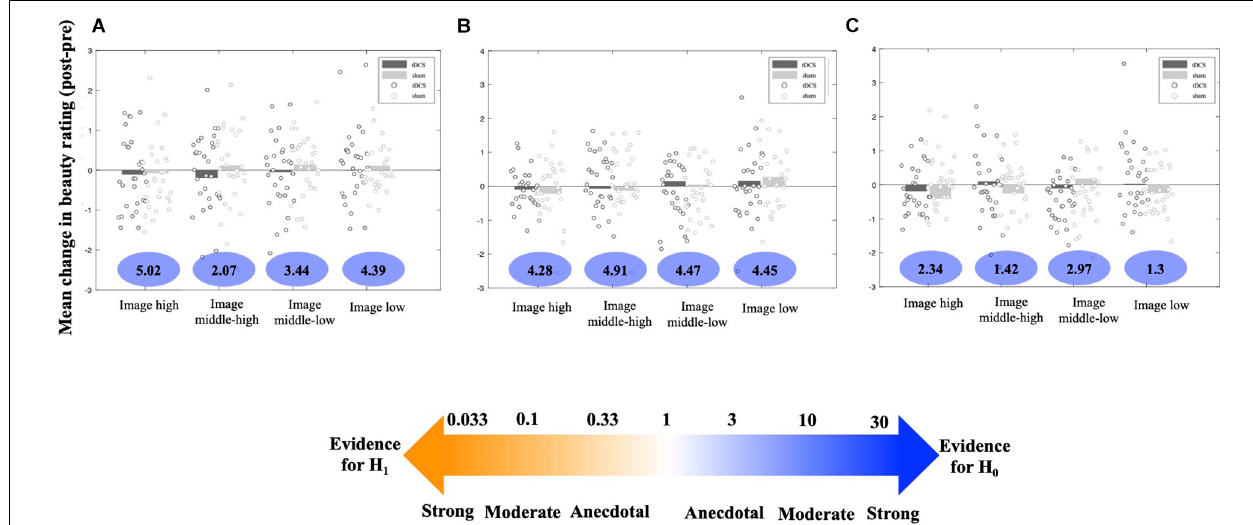
FIGURE 5 | Mean difference in rating scores between post- and pre-stimulation task in tDCS and sham conditions of each image cluster in (A) Experiment 2, (B) Experiment 3 and (C) Experiment 4. Bars represent the mean difference in rating scores of all participants and dots represent the mean rating score differences for each participant. Numbers below the bars are